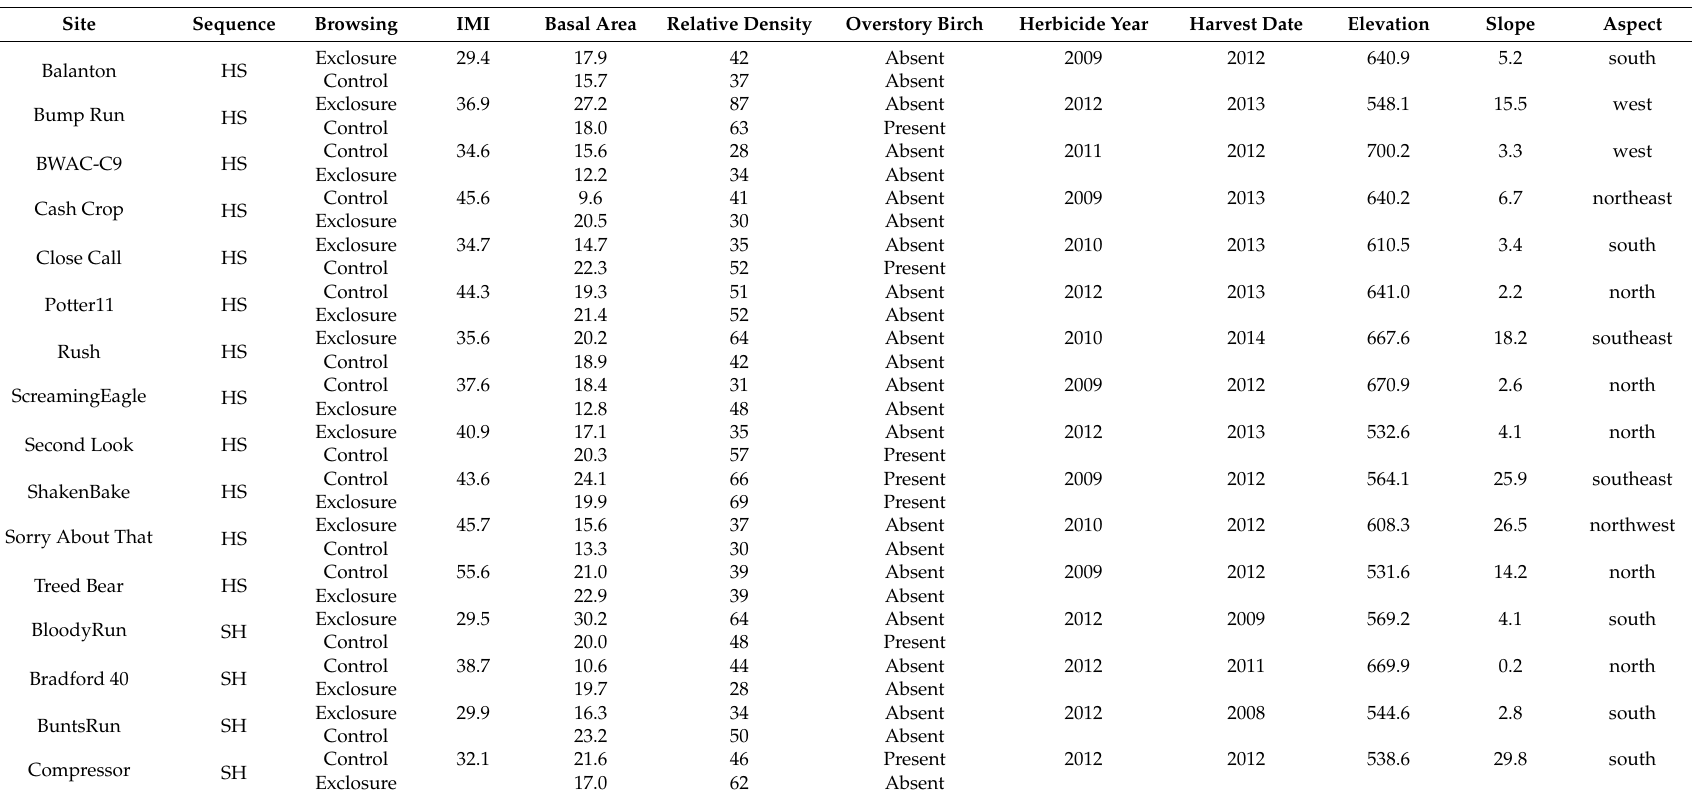
Table A1. Site characteristics of the 22 experimental sites. Sequence denotes whether sites received a herbicide preceding the shelterwood harvest (H–S) or if the herbicide was applied post-harvest (S–H). Browsing refers to the 0.42-ha fenced and unfenced areas. IMI is the integrated moisture index, a metric of soil moisture availability and productivity based on GIS-derived metrics [32]. Basal area is in m 2 per hectare. Relative density is a measure of overstory crowding [33]. Birch seed source (Absent/Present) denotes whether there were any residual canopy birch ( B. allegheniensis or B. lenta ) in the canopy post-shelterwood harvest. We also present elevation (meters), slope (degrees), and aspect for each